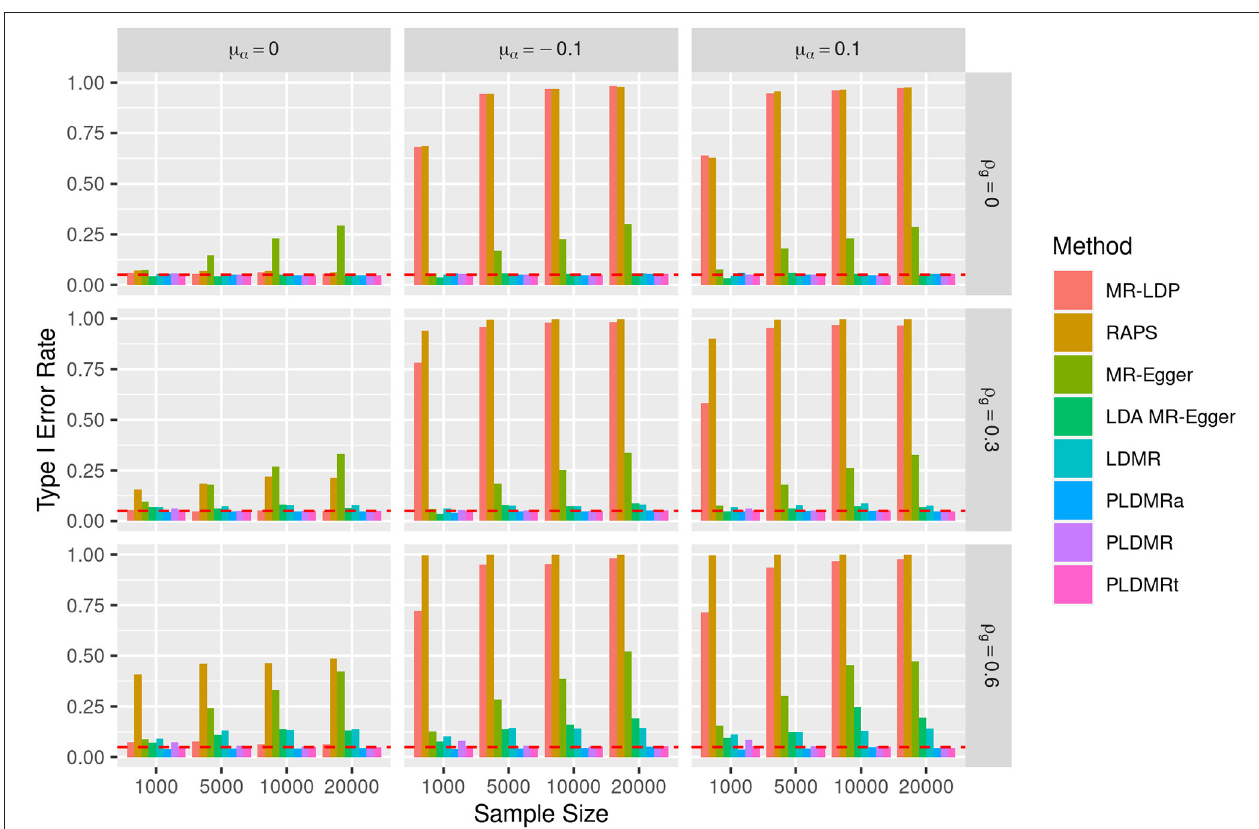
FIGURE 1 | Bar plot of the type I error rates of all methods under the null hypothesis of H 0 : β = 0. Sample size ( n = 1,000, 5,000, 10,000, 20,000), the number of genetic variants m = 25, and σ α = 0.1. µ α = 0, − 0.1,0.1 represents the mean of pleiotropic effect and ρ g = 0,0.3,0.6 stands for the relative strength of LD between the genetic variants. The red dashed horizontal line indicates the nominal significance of